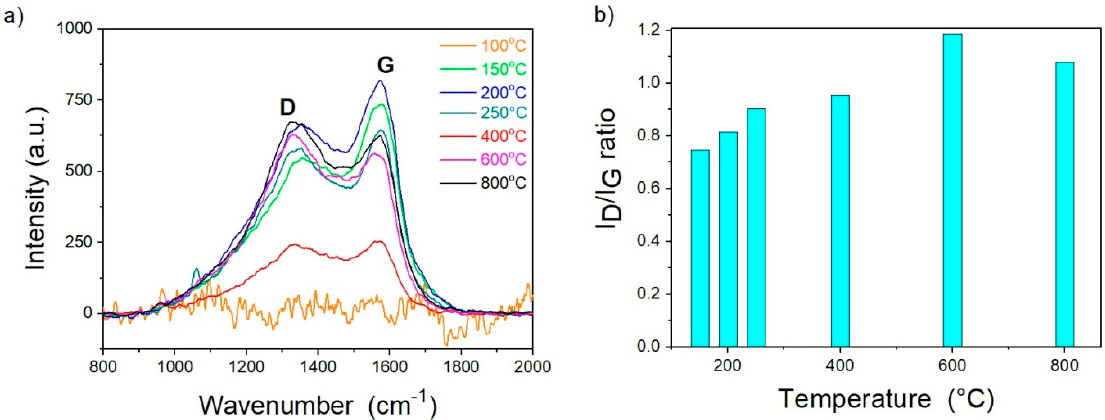
Figure 4. ( a ) Effect of the temperature on the Raman spectra of carrot pulp (CP) treated at various temperatures. ( b ) I D /I G ratio of the pulps on temperature.